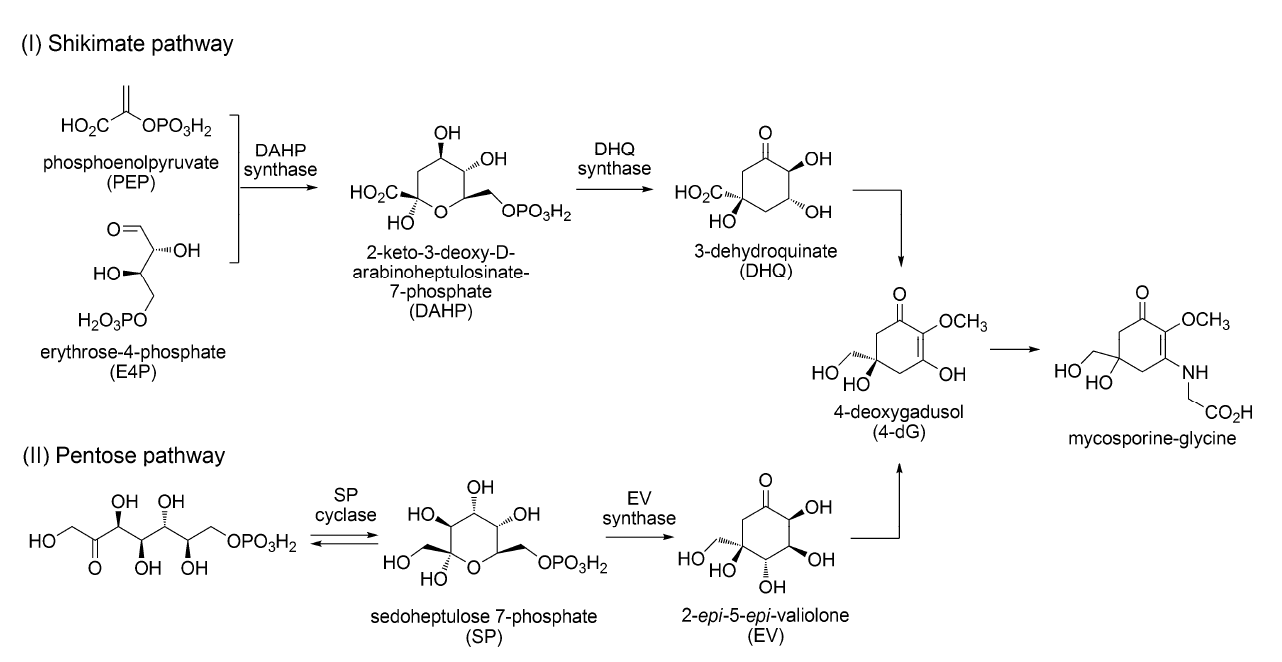
Figure 1. Two possible pathways for the biosynthesis of mycosporine-glycine quoted from references 41, 42 and